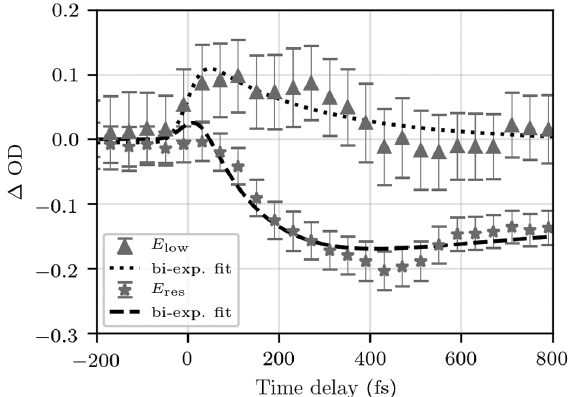
FIG. 3. Δ OD integrated over different spectral regions. In the low-energy range ( E from 49.5 to 49.8 eV), an initial rise with a low subsequent decay can be seen. Integrating over the resonance ( E res from 50.0 to 50.8 eV), the Δ OD shows a smooth decrease. Global fittingofanexponentialmodel[Eq.(1)]totheselineoutsrevealsthe timescales τ 1 ¼ ð 166 (cid:3) 11 Þ fs and τ 2 ¼ ð 290 (cid:3) 30 Þ